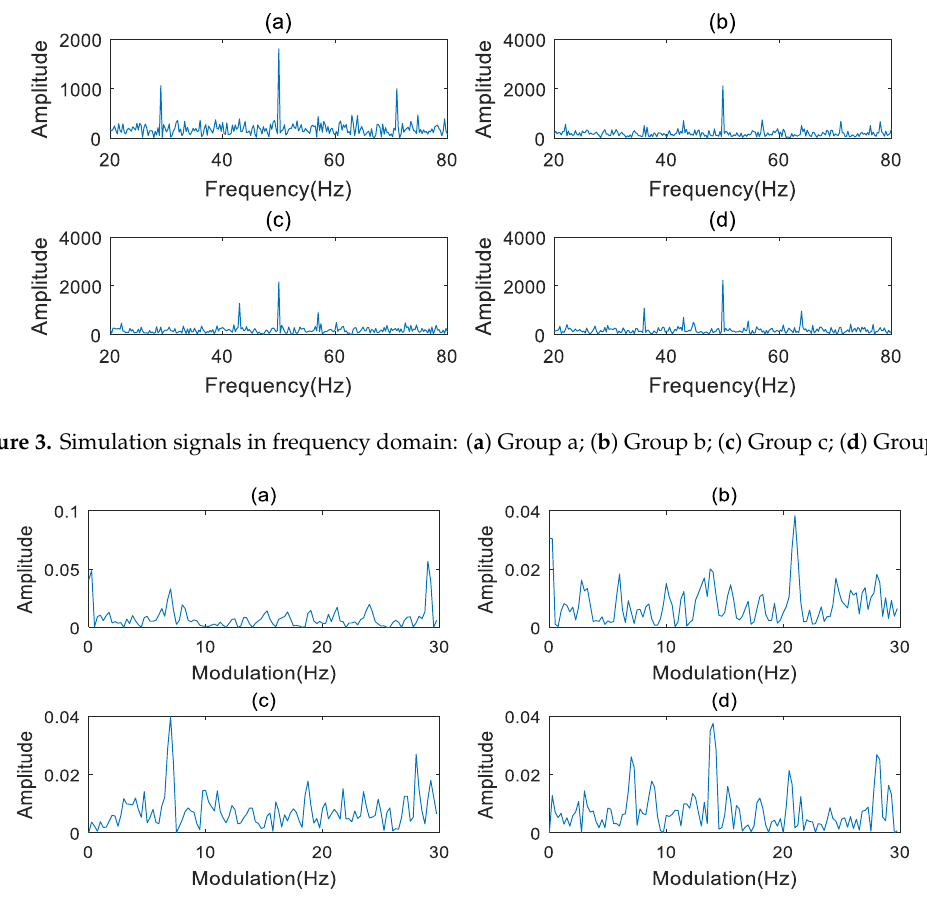
Figure 4. Modulated frequencies on the characteristic slice: ( a ) Group a; ( b ) Group b; ( c ) Group c; ( d ) Group d.